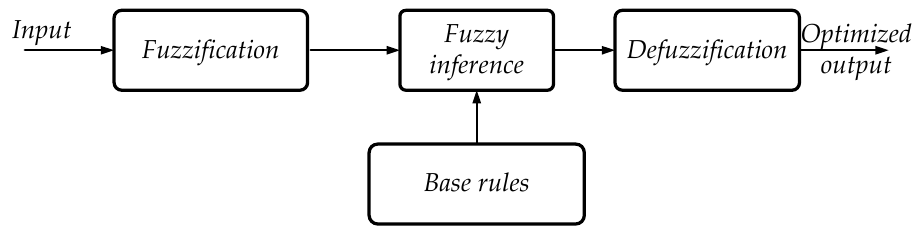
Figure 12. Block diagram of fuzzy